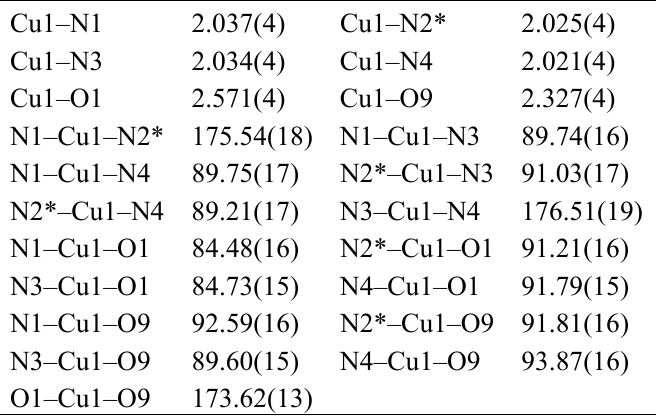
Table 2. Selected bond lengths (Å) and angles (°) of 4